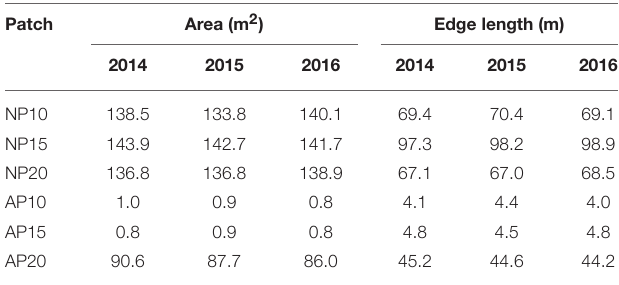
TABLE 1 | Evolution of natural and anthropogenic patch area (m 2 ) and edge length (m) between 2014 and 2016.